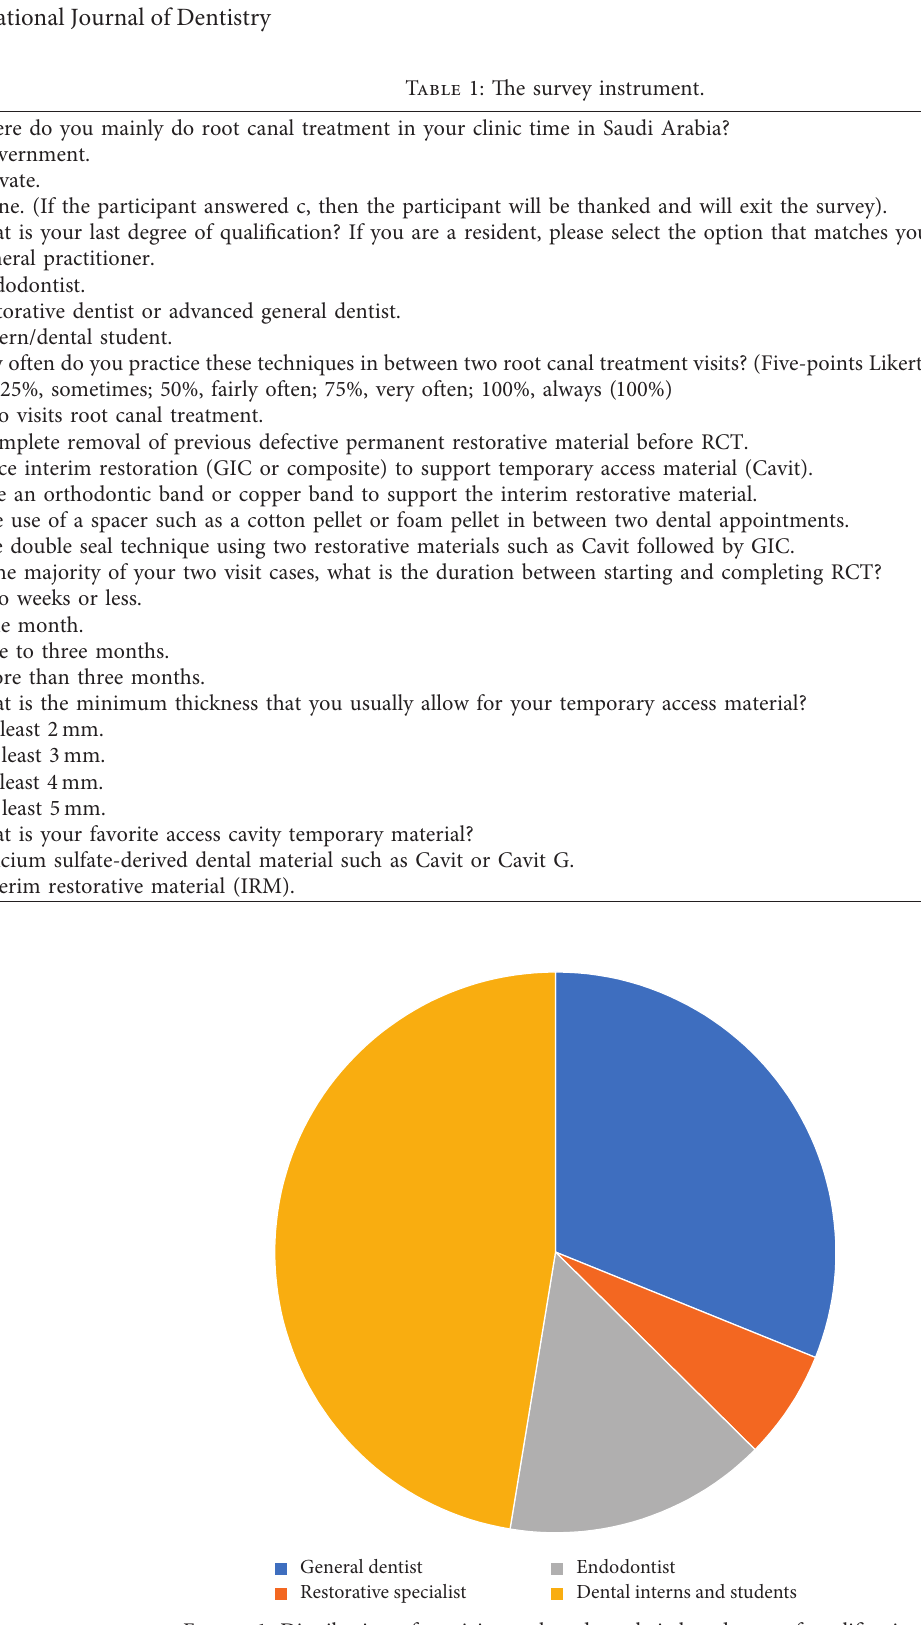
Figure 1: Distribution of participants based on their last degree of